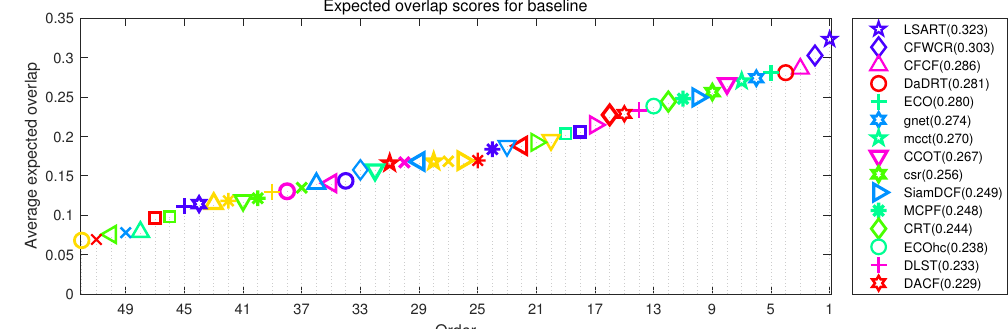
Figure 9. Expected average overlap plot for VOT17 challenge with the proposed Distractor-aware Deep Regression Tracking (DaDRT) tracker. Only the top 15 performing trackers are labeled for clarity. Results are best viewed on high-resolution